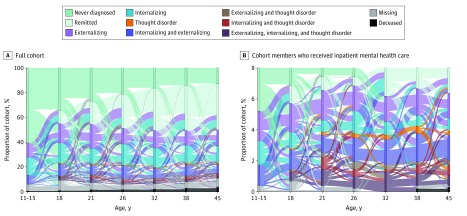
Ebb and Flow of Mental DisordersSankey diagrams show cohort members’ shifting diagnoses from 1 assessment phase to the next, from ages 11 to 15 years to age 45 years. The colors of the horizontal bands divide the diagram into different psychiatric statuses, as indicated in the key. The heights of the horizontal bars show the prevalence of different statuses at each assessment phase. A, Information for the full cohort of 1037 participants. B, Analysis restricted to 83 participants who received inpatient mental-health services (8% of the cohort). Note that it is possible to follow groups across contiguous adjacent assessments, not across the entire panel.